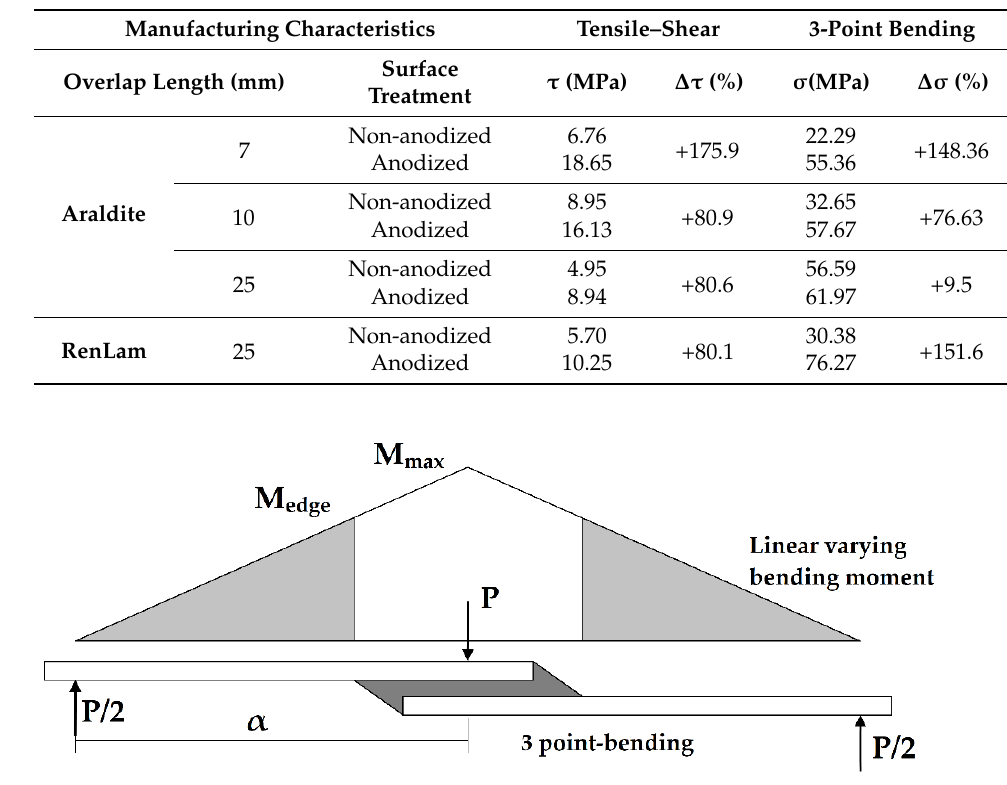
Table 3. Mechanical properties of aluminum adhesive joints.